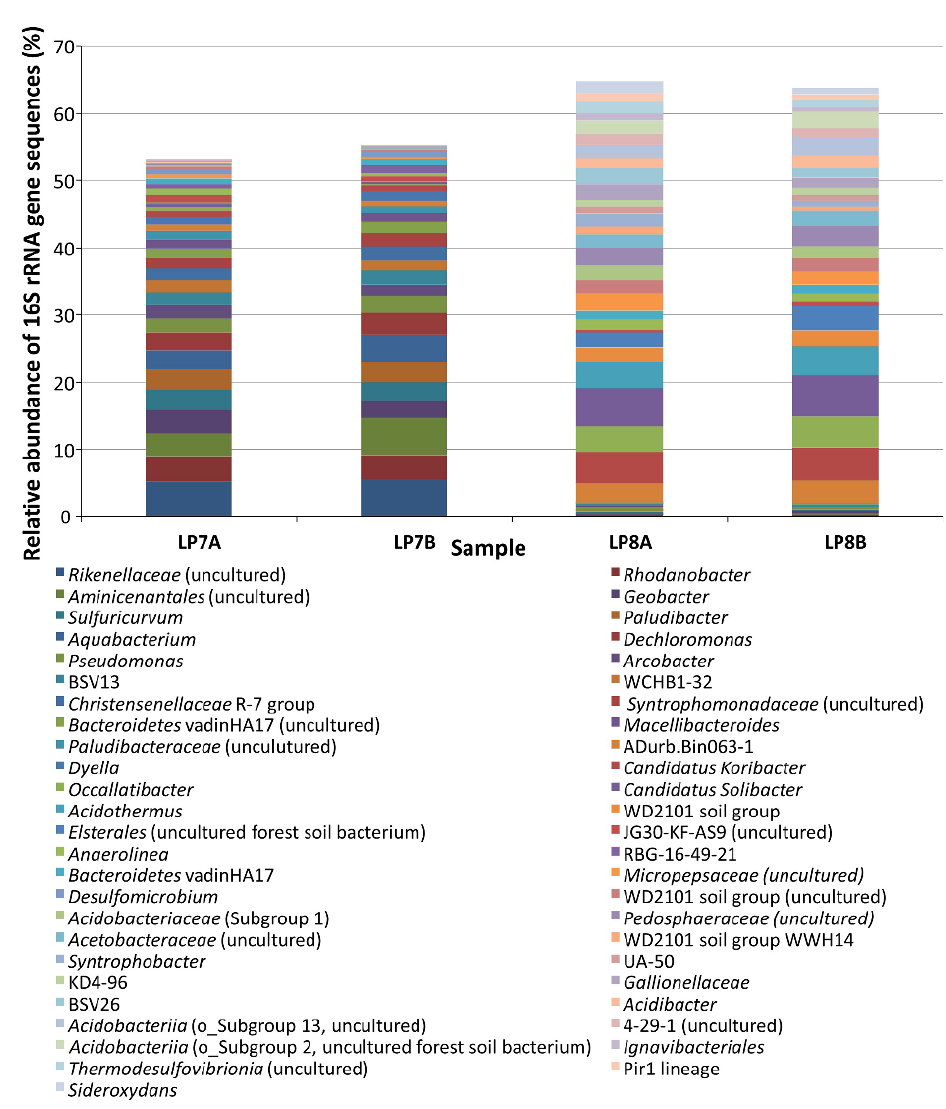
Figure 6. Bacterial diversity in the organic matter-rich sediments from La Playa dam. LP7A and LP7B are samples that are permanently flooded. LP8A and LP8B are samples that are periodically emerged. “A samples” belong to the surficial part of the core sediment, whereas “B samples” were taken from the deepest part of the core sediment in LP7 and LP8 sampling points. 16S rRNA sequences with a relative abundance of at least 1% are shown. Sequences were assigned to genus level or the corresponding higher taxonomic group.